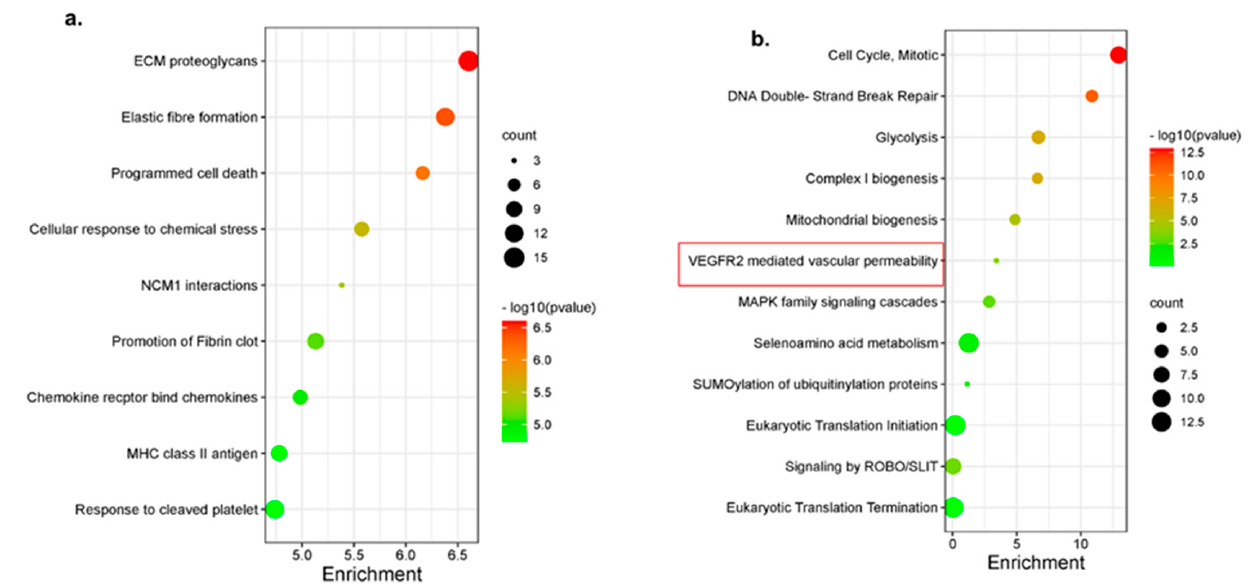
Figure 3. Pathway alterations upon Disarib treatment in EAC mouse tumour. ( a ) A bubble plot depicting upregulated pathways ( b ) A bubble plot depicting downregulated pathways. The x -axis represents enrichment and y -axis pathways. The size of the circle represents gene count, and the colouring is based on − log10 ( p -value).